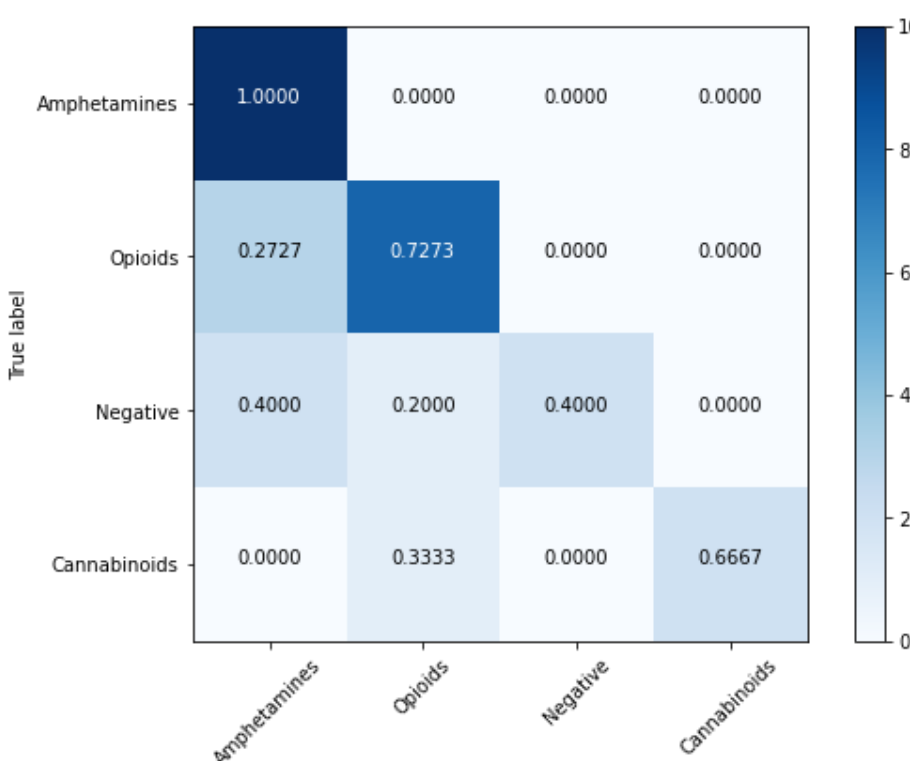
Figure 9. Confusion matrix for the KNN model.